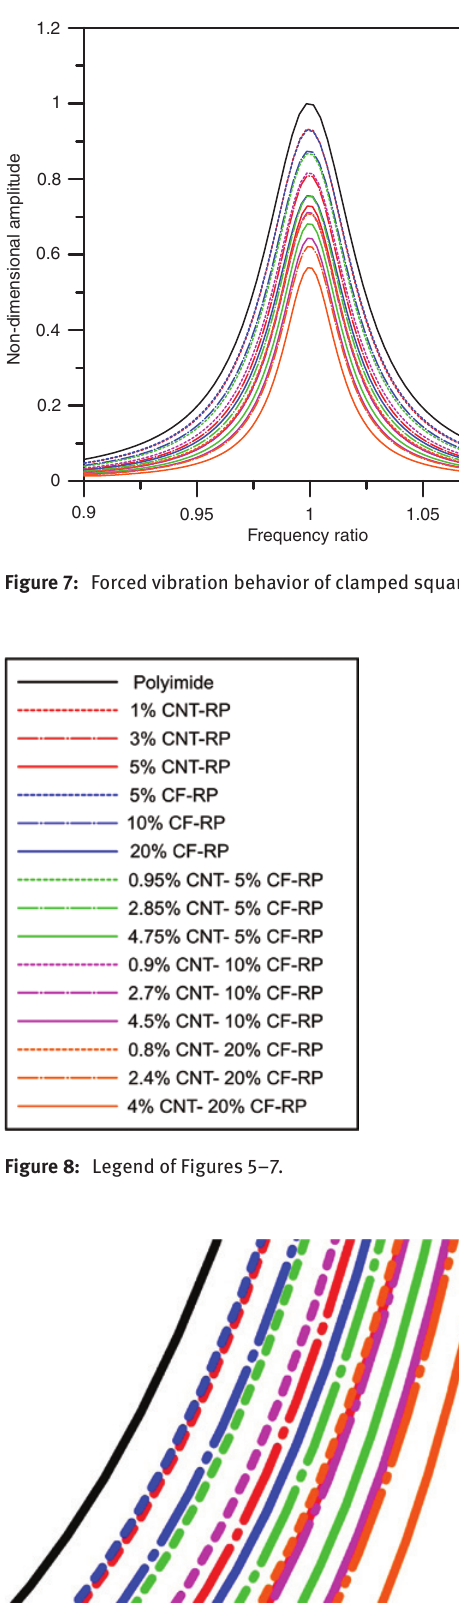
Figure 9: A close view of amplitude-frequency ratio curves for clamped circular